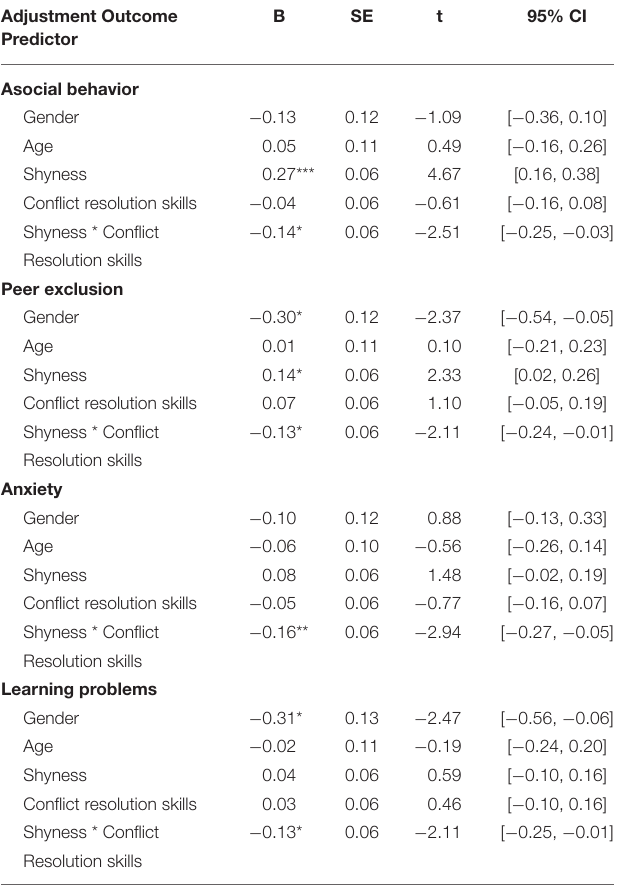
TABLE 2 | Contributions of shyness, conflict resolution skills, and their interaction in predicting adjustment. Adjustment Outcome